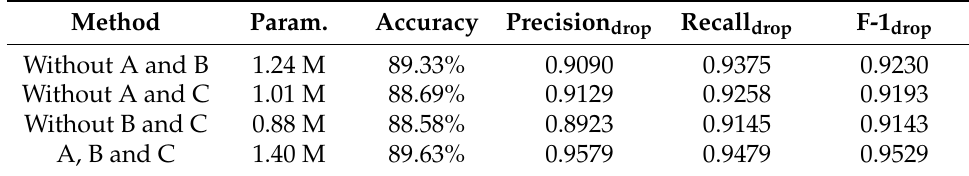
Table 4. The ablation experiment results for “drop” behavior.